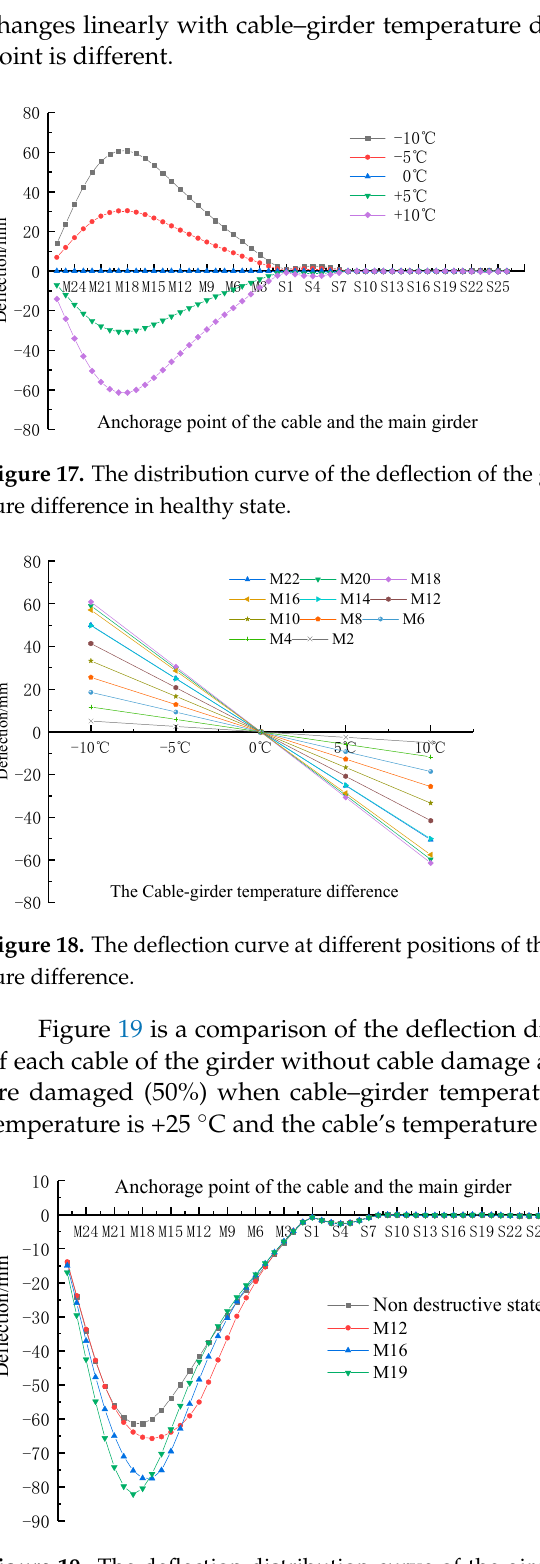
Figure 19. The deflection distribution curve of the girder in nondestructive state and after cable damaged (50%) at cable–girder temperature difference of +10 °C.